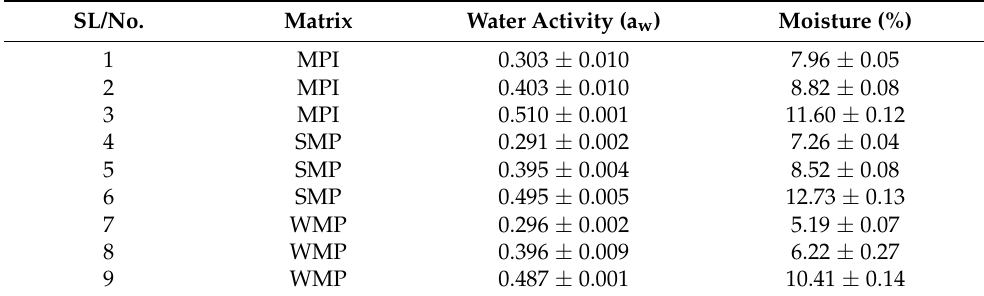
Table 2. Water Activity and Product Moisture Content of Powders Obtained with Fluidized Bed Drying Using Different Encapsulating